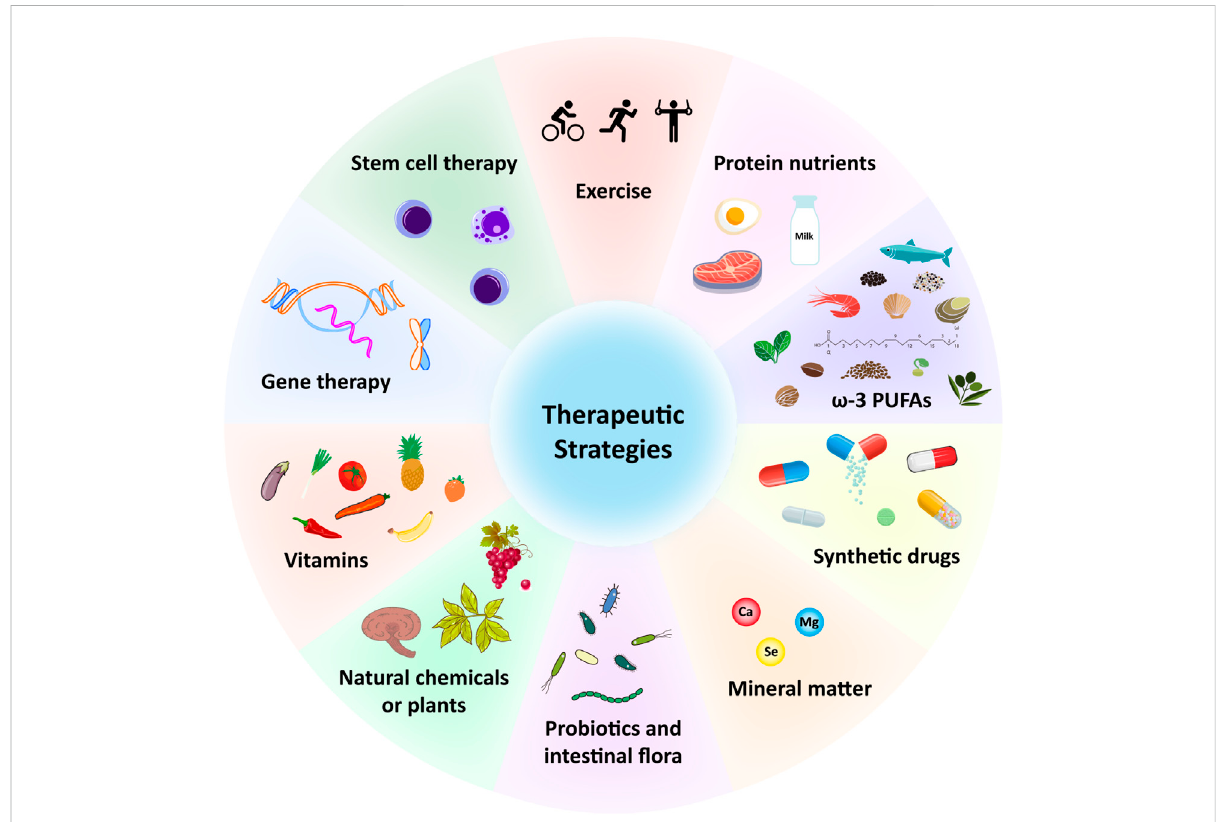
FIGURE 2 Potential therapeutic strategies for sarcopenia during aging. ω -3, Omega-3; PUFAs, Polyunsaturated fatty acids; Ca, Calcium; Mg, magnesium; Se,